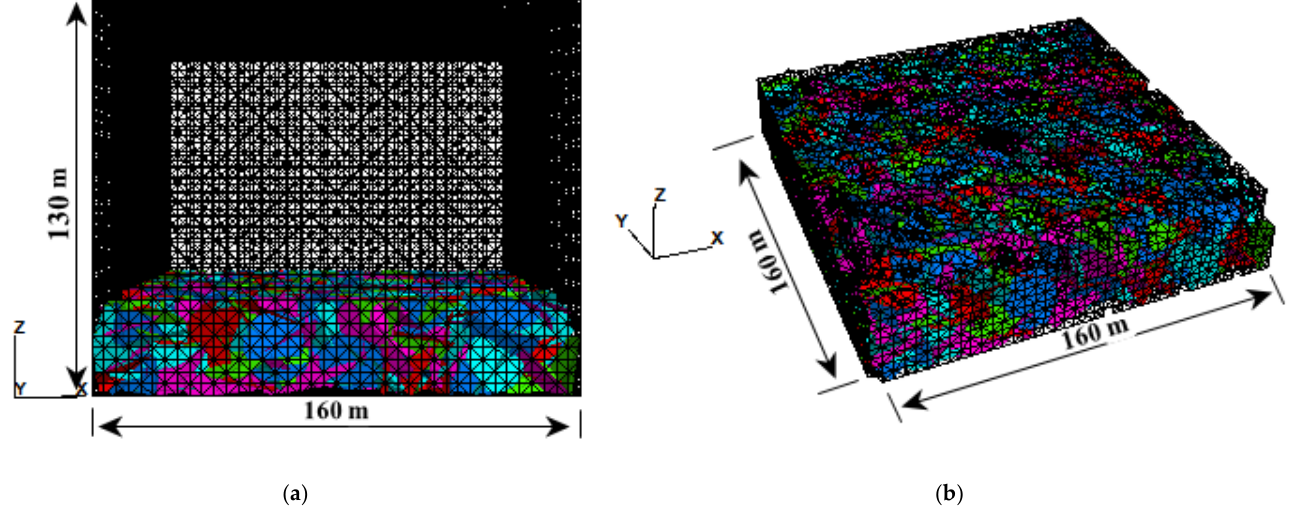
Figure 18. Calculation model diagram of the shaft. ( a ) Shaft 1 main shaft permeability coefficient equivalent with stochastic area, ( b ) Area of random distribution of permeability coefficients.